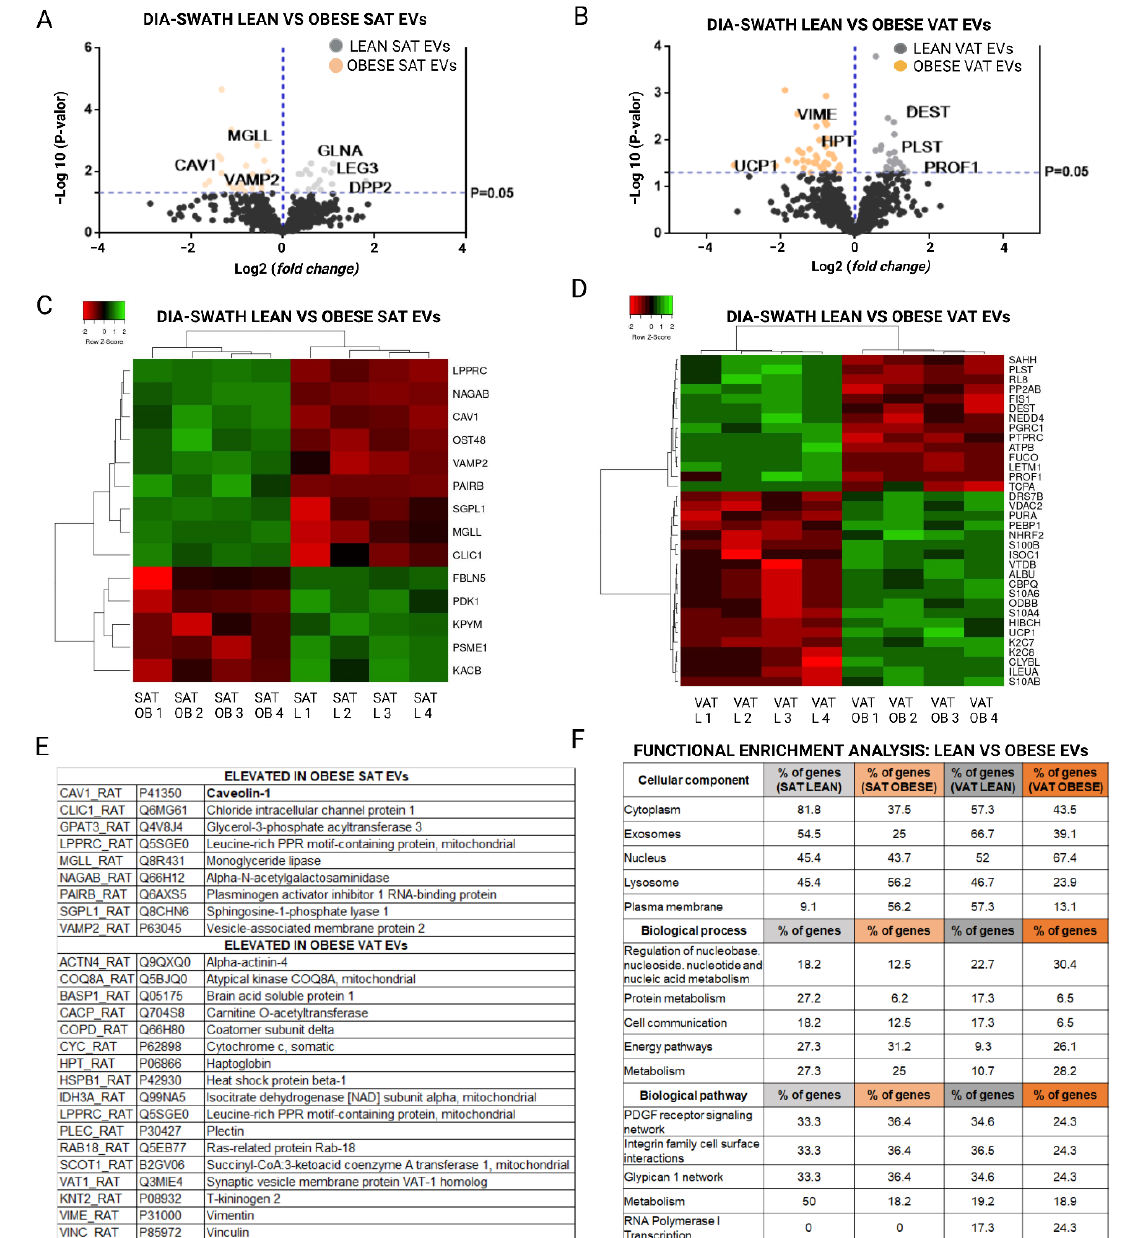
Figure 4. Quantitative DIA-SWATH/MS analysis of protein content in EVs secreted by subcutaneous adipose tissue (SAT) and visceral adipose tissue (VAT) in normal (control) and obese animals. ( A , B ) A volcano plot representation of elevated proteins in SAT EVs and VAT EVs from lean versus obese animals with a fold change >1.5; ( C , D ) cluster analysis by heat map representation of proteins in SAT EVs and VAT EVs with a fold change ≥ 2 and a p -value ≤ 0.05. ( E ) summary table with elevated proteins in EVs released from SAT and VAT of obese animals; ( F ) classification of the comparative functional enrichment (FunRich basis) according to cellular component, process, and biological pathway of the elevated proteins in SAT EVs and VAT EVs from normal (grey) and obese (orange) animals ( F